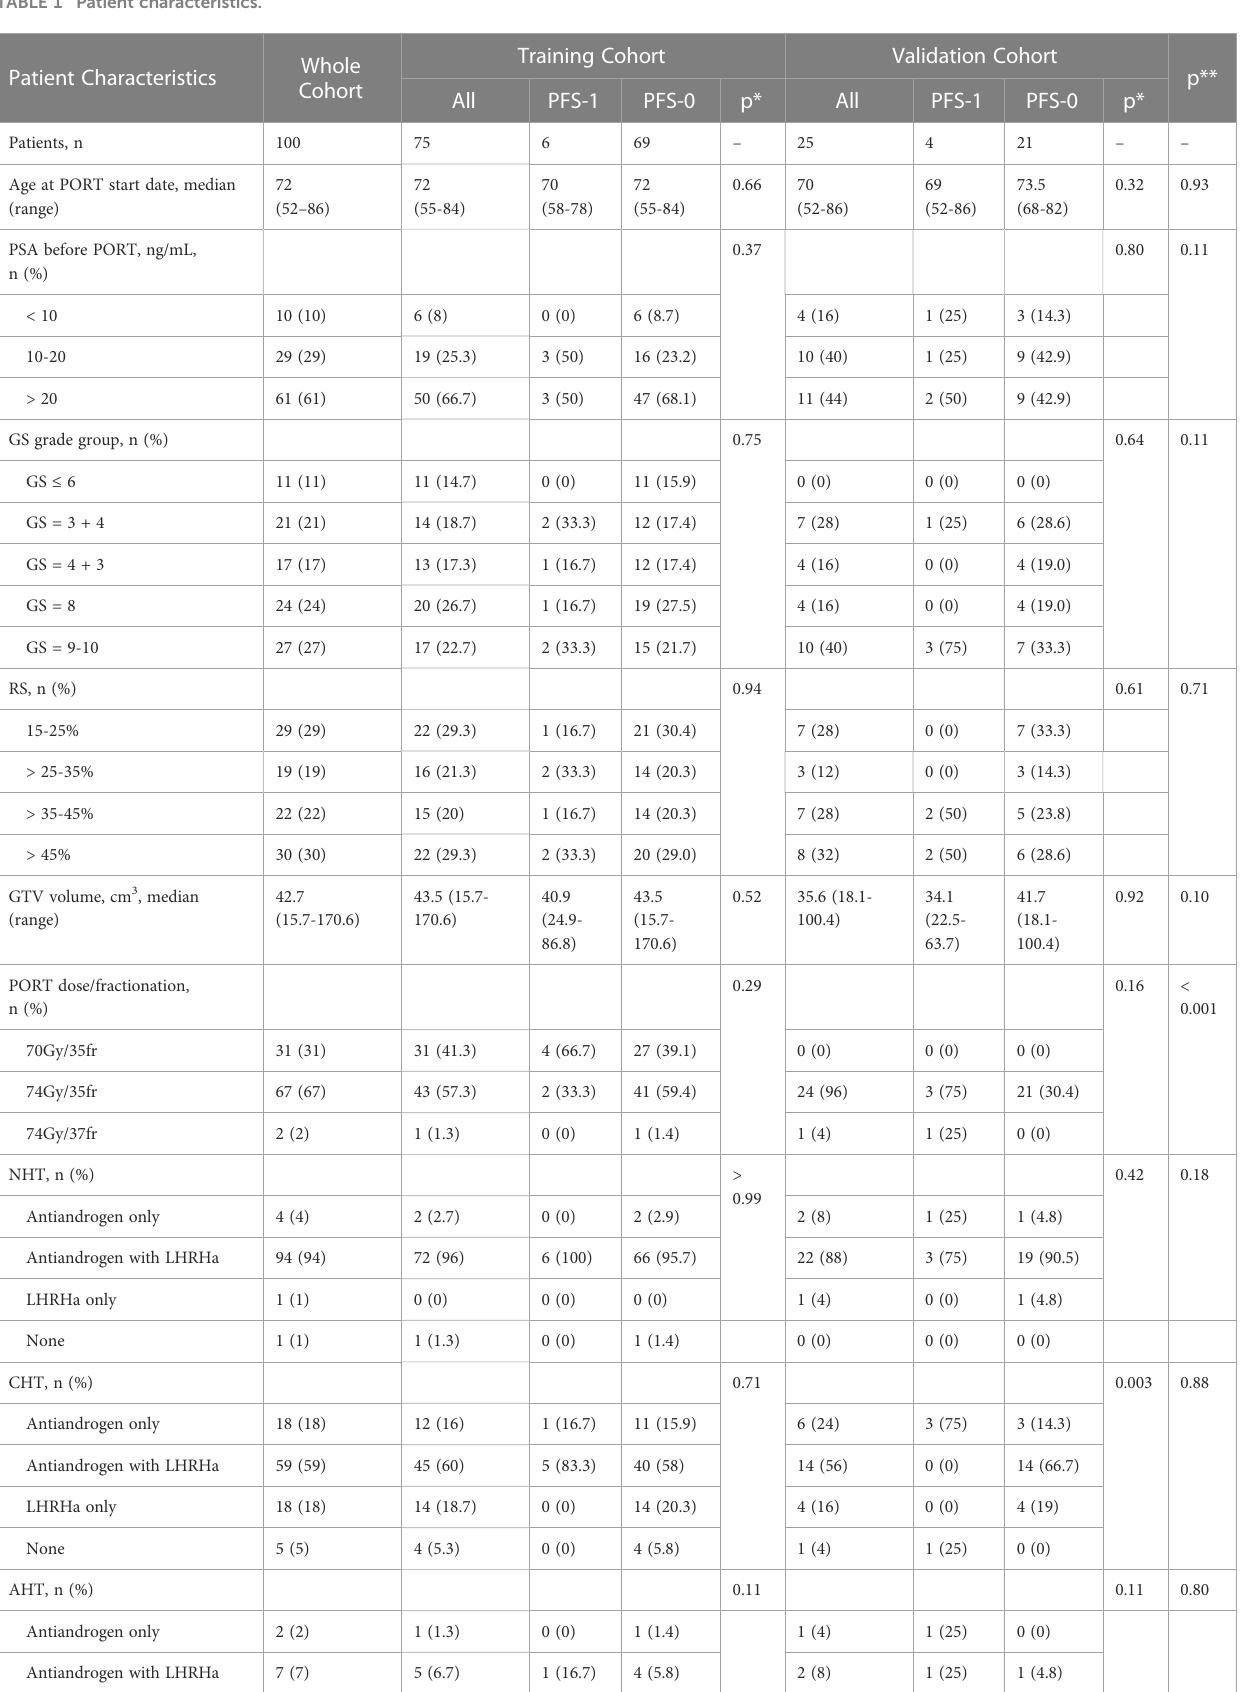
TABLE 1 Patient